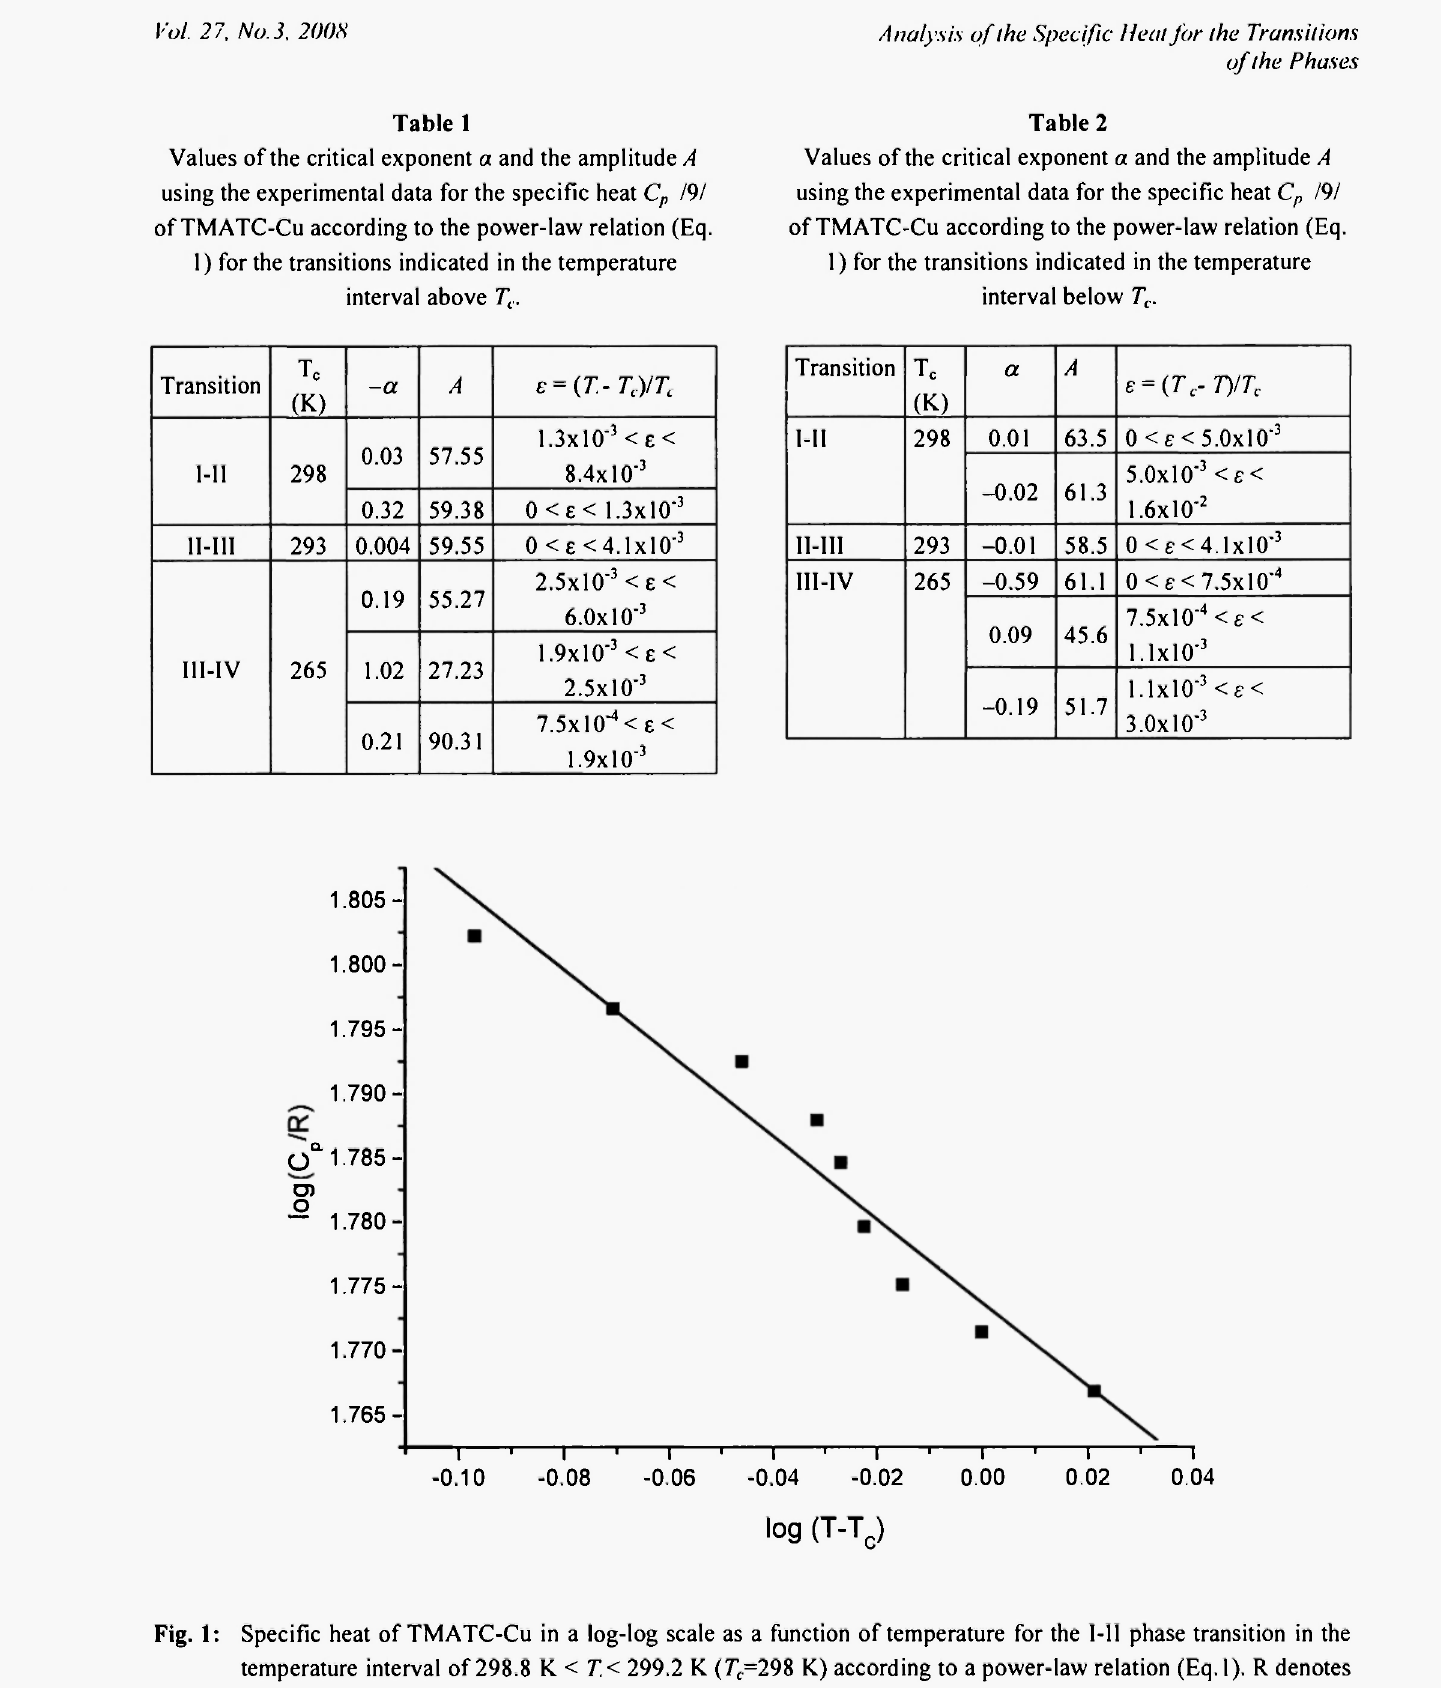
Fig. 1: Specific heat of TMATC-Cu in a log-log scale as a function of temperature for the I—11 phase transition in the temperature interval of 298.8 Κ < T< 299.2 Κ (T c = 298 K) according to a power-law relation (Eq.l). R denotes the gas